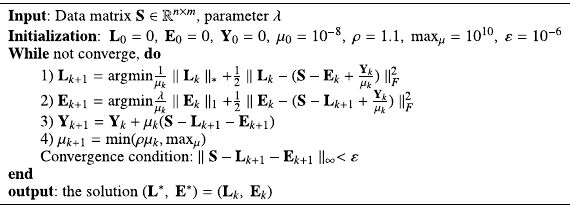
Algorithm 1: RPCA problem using